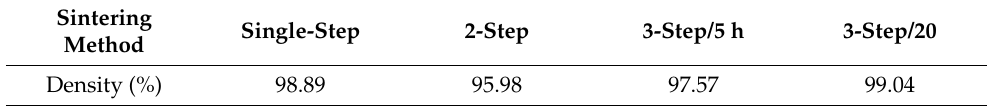
Table 1. Density values for ceramics prepared using different sintering methods.